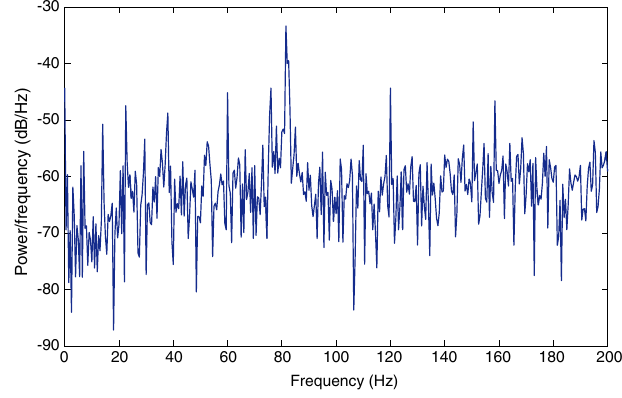
FIG. 14. Spectrum of the phase error